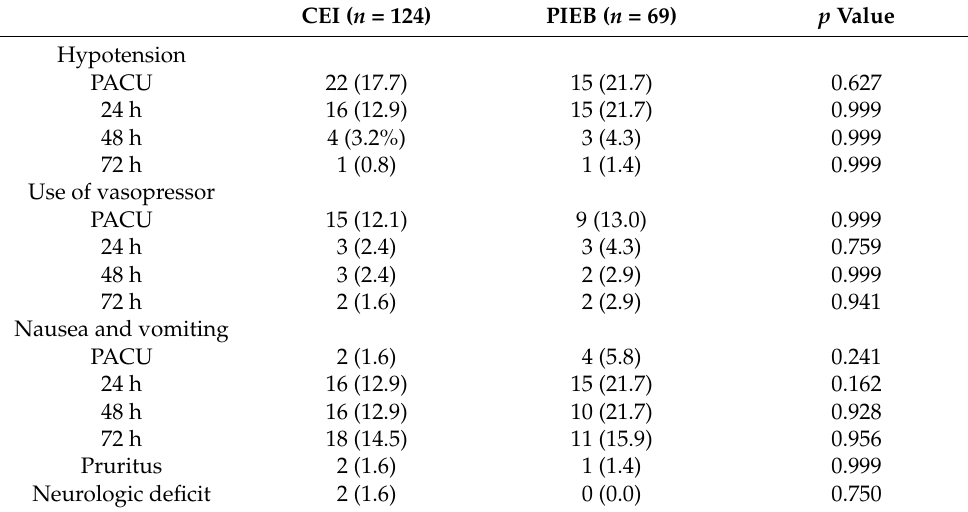
Figure 3. Comparison of pain intensity in the PACU at 12, 24, 48, 72 h after surgery between PIEB and CEI groups. A. Comparable worst pain scores between the PIEB and CEI groups. B. Comparable average pain scores between the PIEB and CEI groups. CEI, continuous epidural infusion; PIEB, programmed intermittent epidural bolus; NRS; numeral rating scale; PACU, post-anesthesia care unit. Results are expressed as box and whisker plots, including media, 10th, 25th, 75th, and 90th percentiles. Table 3. Incidence of adverse